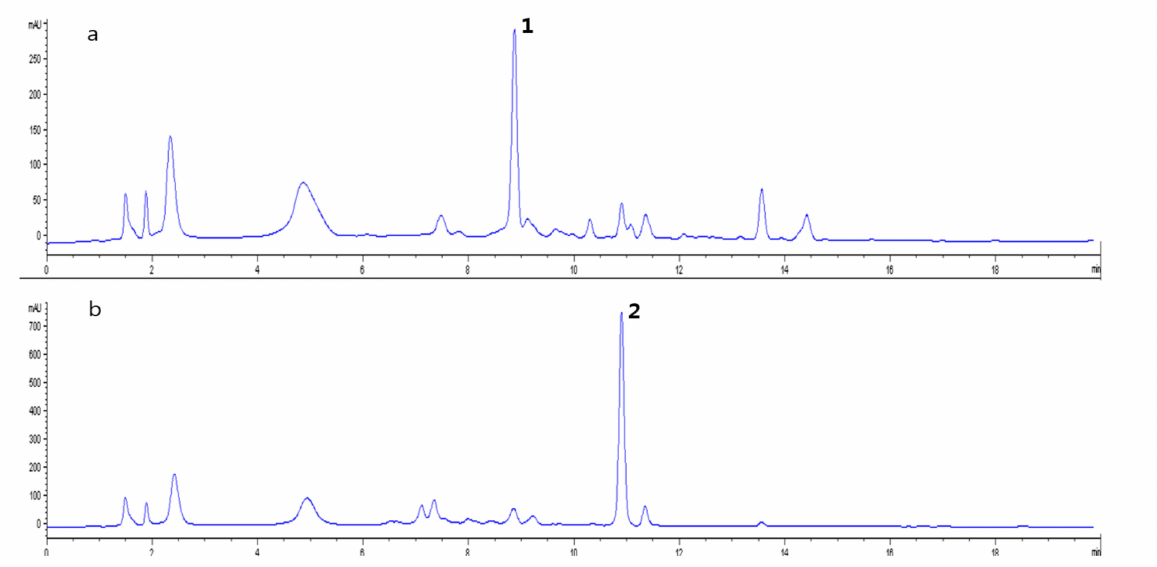
Figure 4. HPLC traces (detected at 310 nm) of ( a ) the ethyl acetate-soluble fraction of L. chinense and ( b ) L.barbarum extracts. Thesepeakswereidentifiedas4-(2-formyl-5-(hydroxymethyl)-1 H -pyrrol-1-yl)butanoic acid ( 1 ) and p -coumaric acid ( 2 ), respectively. The HPLC samples were prepared with 2 mg / mL of the extract by injecting 15 µ L of each sample.